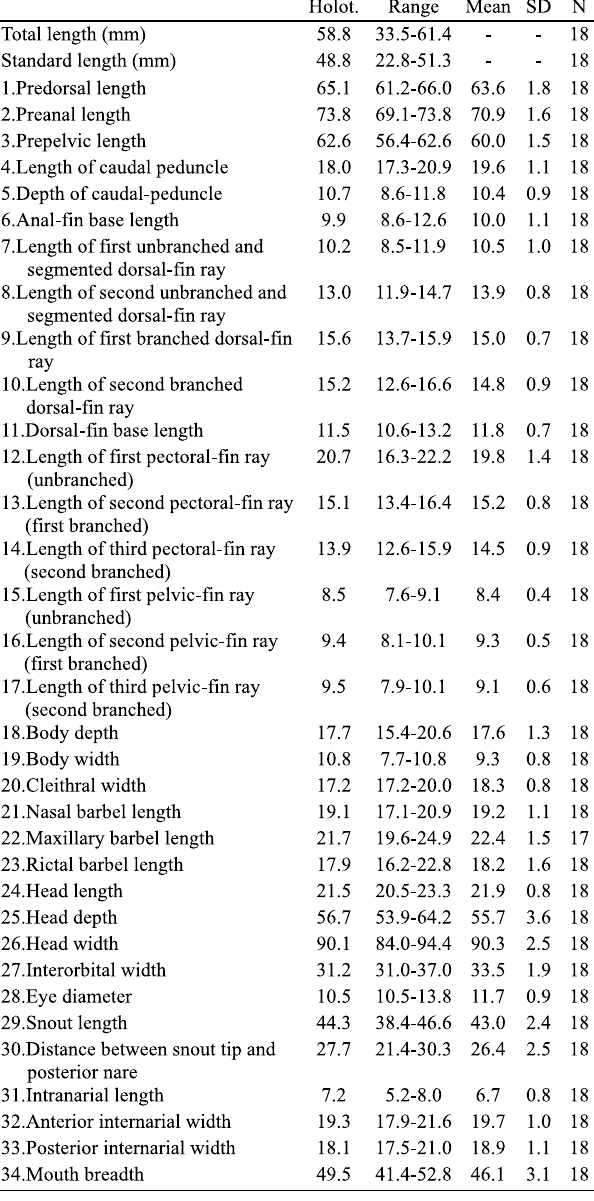
Table 1. Morphometrics of Trichomycterus maracaya (holotype: ZUEC 6137; paratypes: LIRP 4381, MCP 34575, MNRJ 25872, MZUSP 83357, and ZUEC 4115 and 6136). Values 1 through 24 are percents of standard length; values 25 through 34 are percents of head